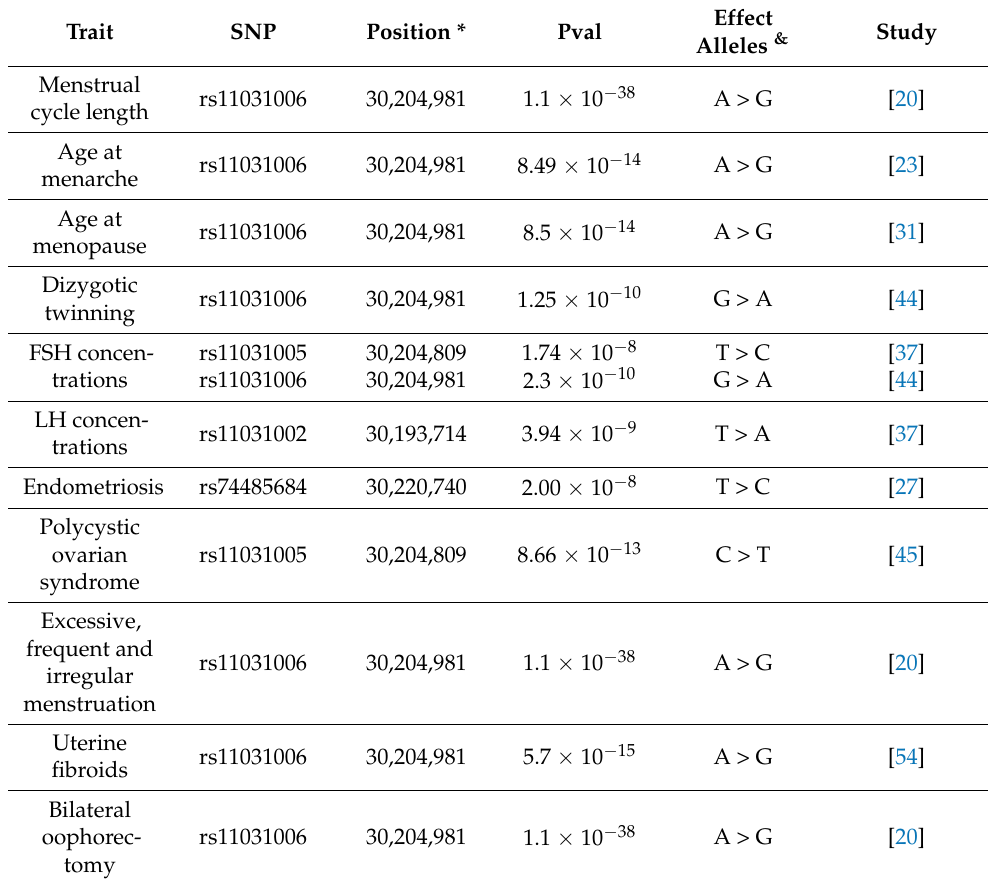
Table 3. Genetic association for common traits and diseases immediately upstream of the follicle stimulating hormone subunit beta ( FSHB ) on chromosome